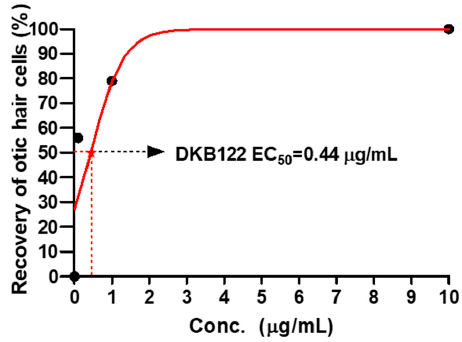
Figure 2. Dose-effect curves of DKB122. The EC 50 of DKB122 was 0.44 µg/mL.